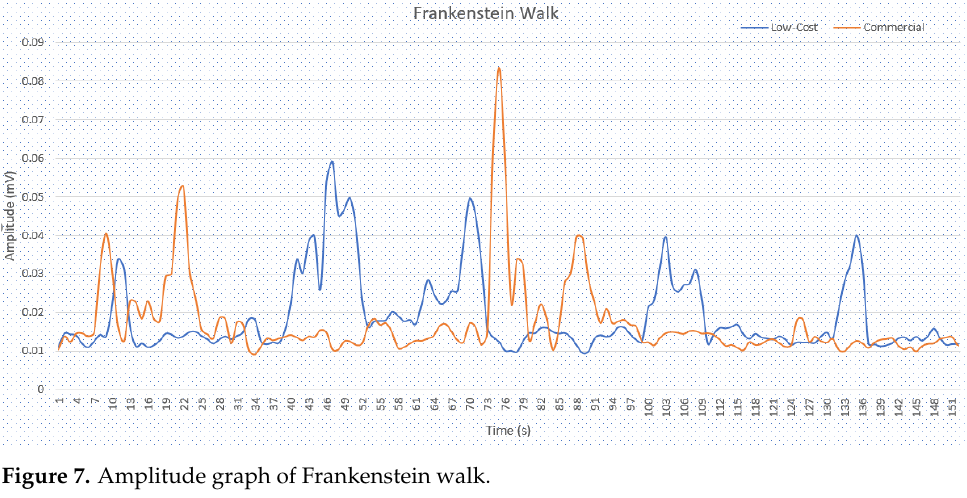
Figure 7. Amplitude graph of Frankenstein walk.